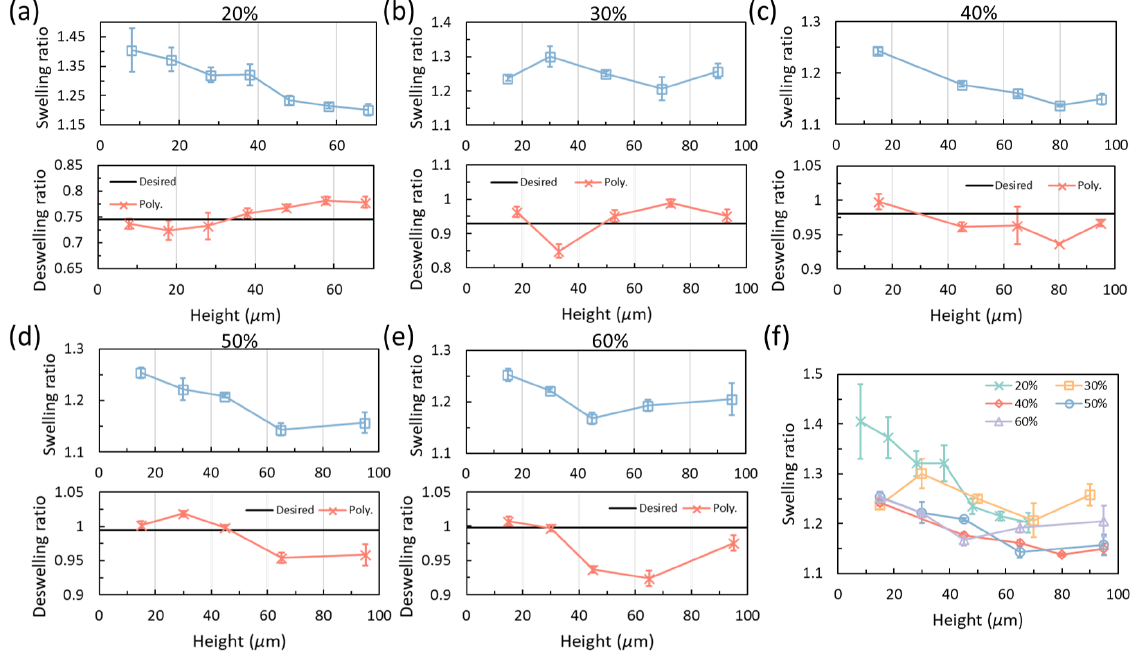
Figure 6. Verification prints using polynomial fitting of the piecewise-linear calibration results for different powers. ( a ) Results for 20% power. ( b ) Results for 30% power. ( c ) Results for 40% power. ( d ) Results for 50% power. ( e ) Results for 60% power. Upper plots in ( a – e ) are swelling ratios in alkaline solution and lower plots are in DI water. ( f ) Swelling ratios for different initial powers in alkaline